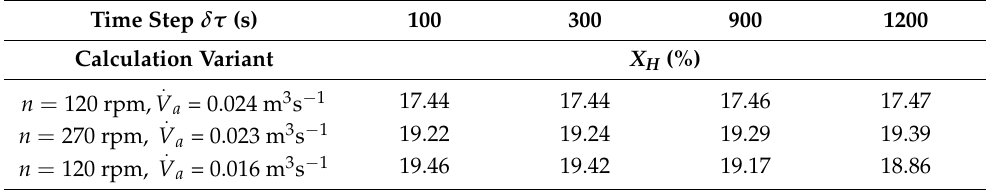
variants of calculations is presented in Table 3. Table 3. Effect of the time step on honey moisture calculation results τ =